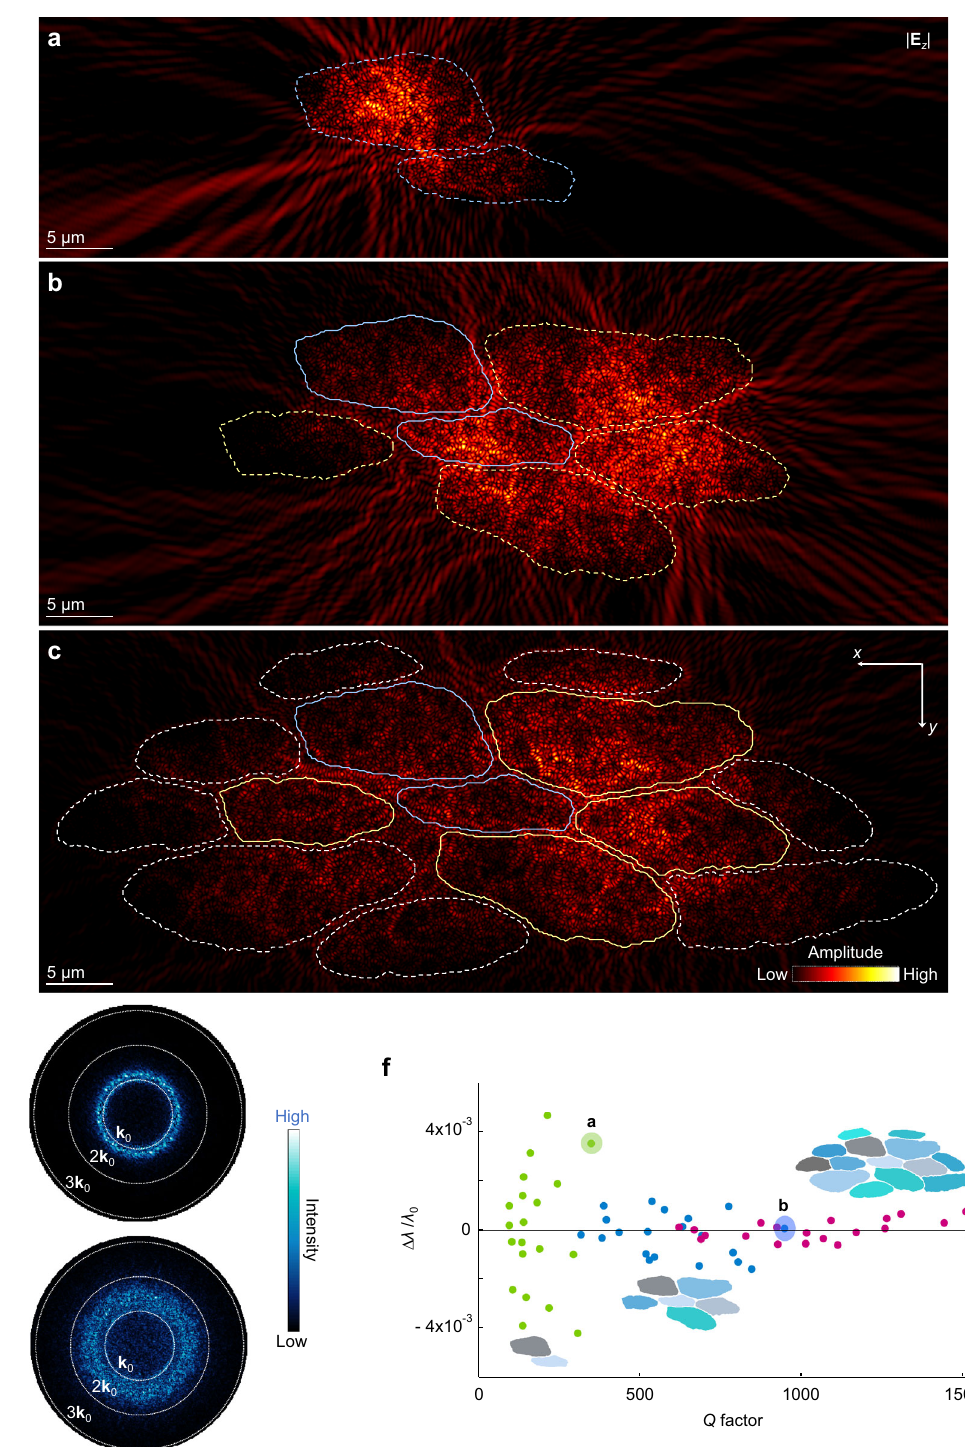
Fig. 3 Prediction of light localization. a – c Electric fi eld amplitude | E z | of modes in 2-cohesively ( a ), 6-cohesively ( b ) and 14-cohesively ( c ) bonded stacks of silk fi laments (with nano fi brillar structures) at the wavelengths marked by the larger circles in f . The inner boundaries of sericin layers are marked by the coloured lines. d , e Norms of the Fourier transform of the electric fi eld E z of a , c , respectively. f Q factors of adjacent 20 modes around λ 0 = 600 nm. The green, blue and red dots correspond to the 2- fi lament, 6- fi lament and 14- fi lament structures,